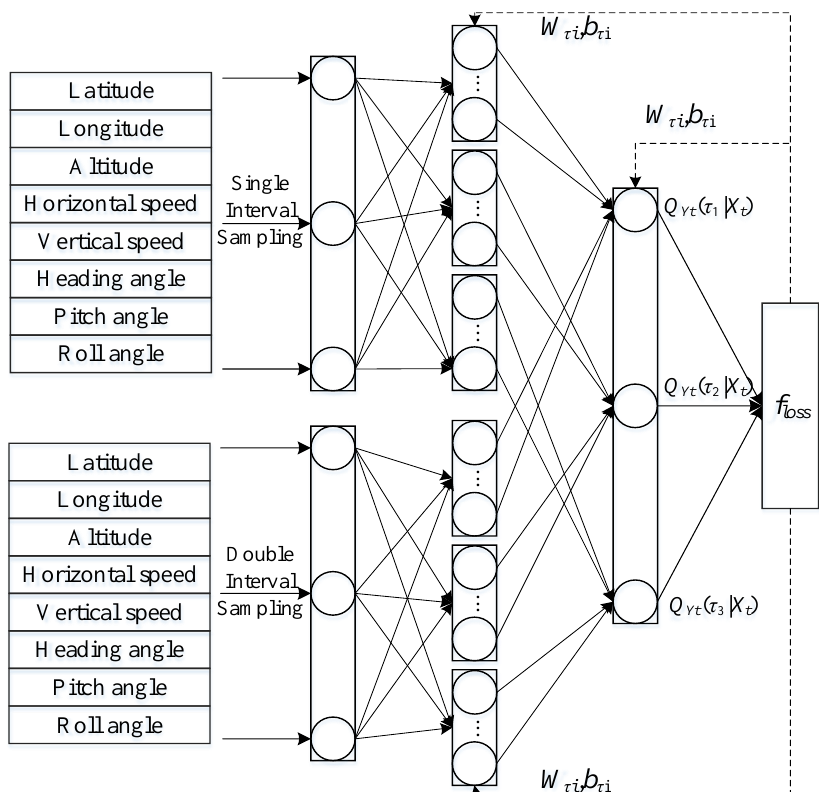
Figure 3. Structure of the QRDGRU